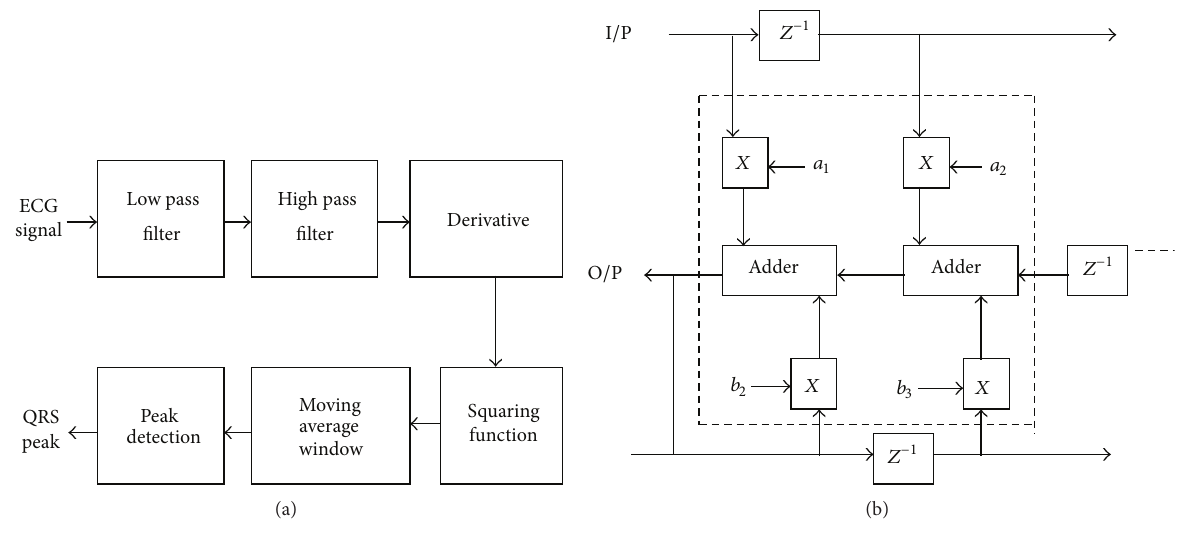
Figure 1: (a) QRS detection steps [6]. (b) Digital filter of QRS detector